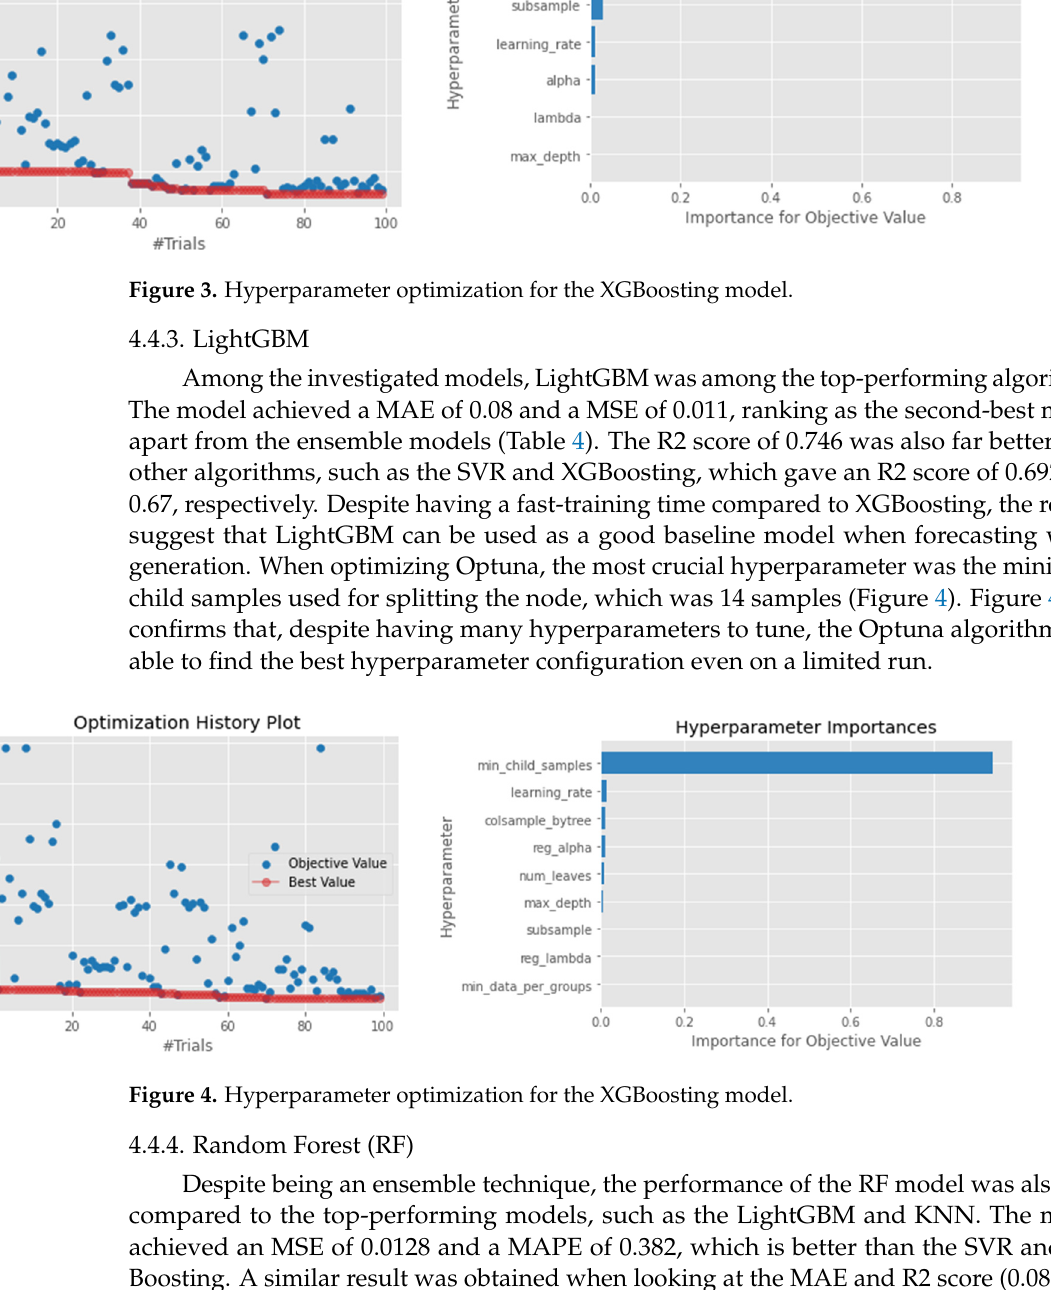
to be tuned. The best performance of the model was achieved by using a learning rate of